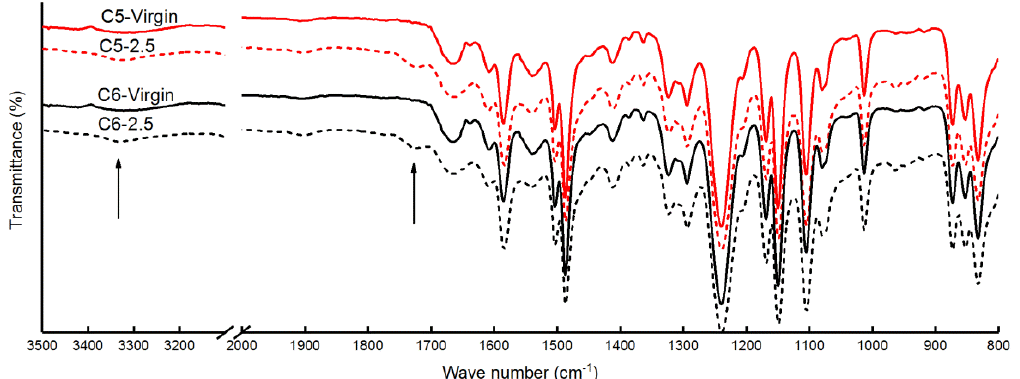
Figure 7. The FT–IR spectra of RO membranes before and after 6 months of exposure to the acid solutions containing 2.5% acrylic acid and 2.5% acetic acid.